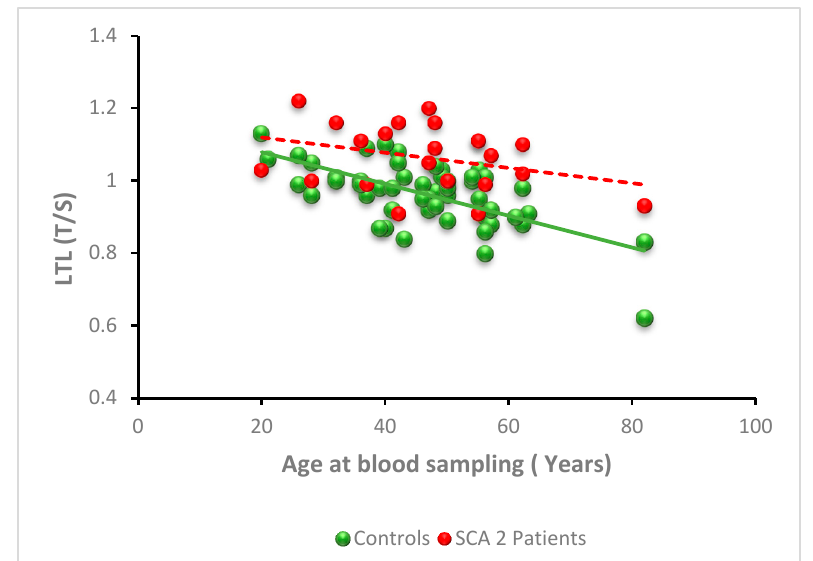
Figure 4. Relationship between LTL and age at blood sampling in SCA2 patients. LTL expressed as T/S ratio as a function of age at blood sampling in SCA1 patients (n = 26; red spheres) and controls (n = 52; green spheres). While in controls there is a significant negative correlation between LTL and age at blood sampling ( p < 0.0001), in SCA2 this correlation is absent ( p = 0.10). This is due to the maintenance of LTL in different ages. The LTL values of SCA2 patients are statistically significantly higher than controls from 40 years of age